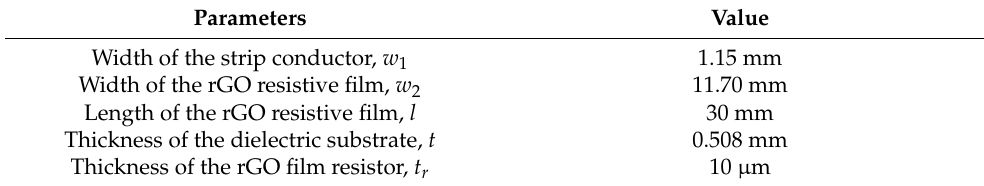
Table 1. The parameters of the